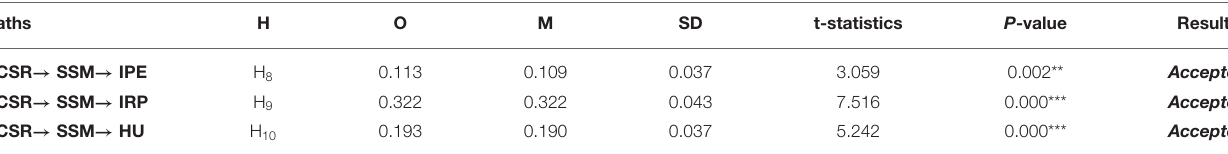
TABLE 6 | Indirect effects of the variable. Paths H O